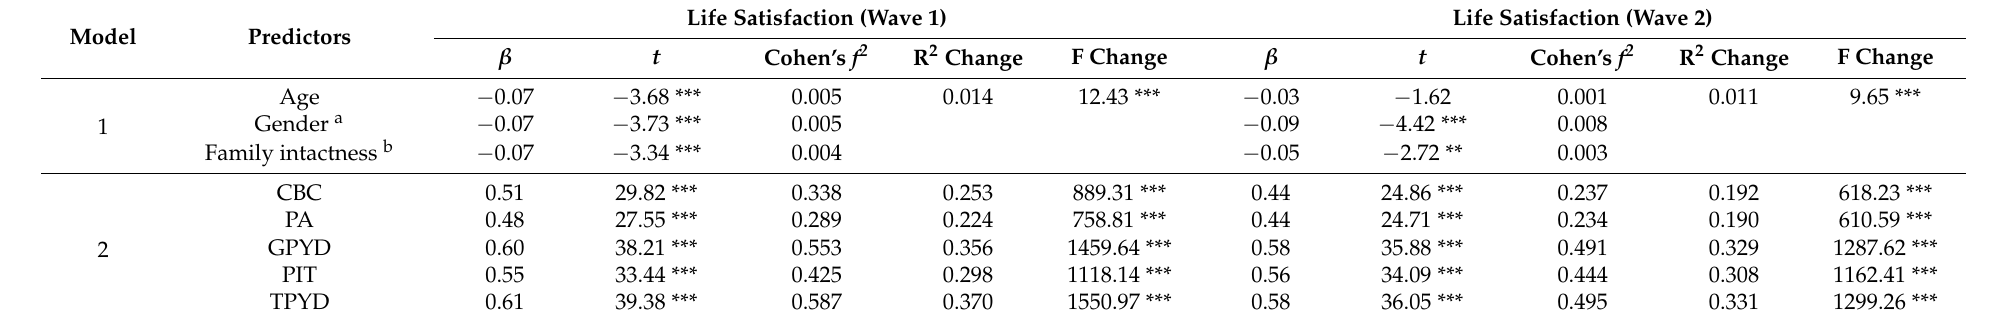
Table 5. Cross-sectional regression analyses for life